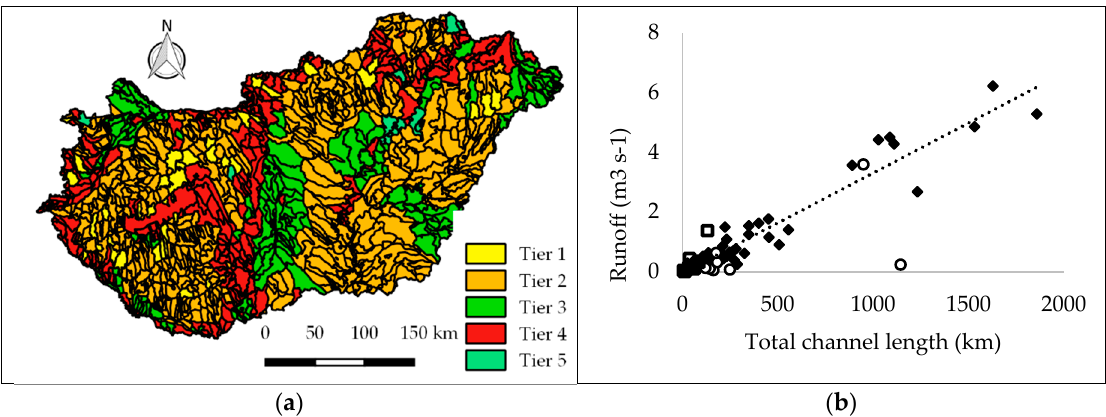
Figure 5. ( a ) Methods used for runoff estimation throughout the country. ( b ) measured average annual runoff vs. total channel length on the catchment. Hollow rounds: outliers from sandy catchments; squares: karstic areas.